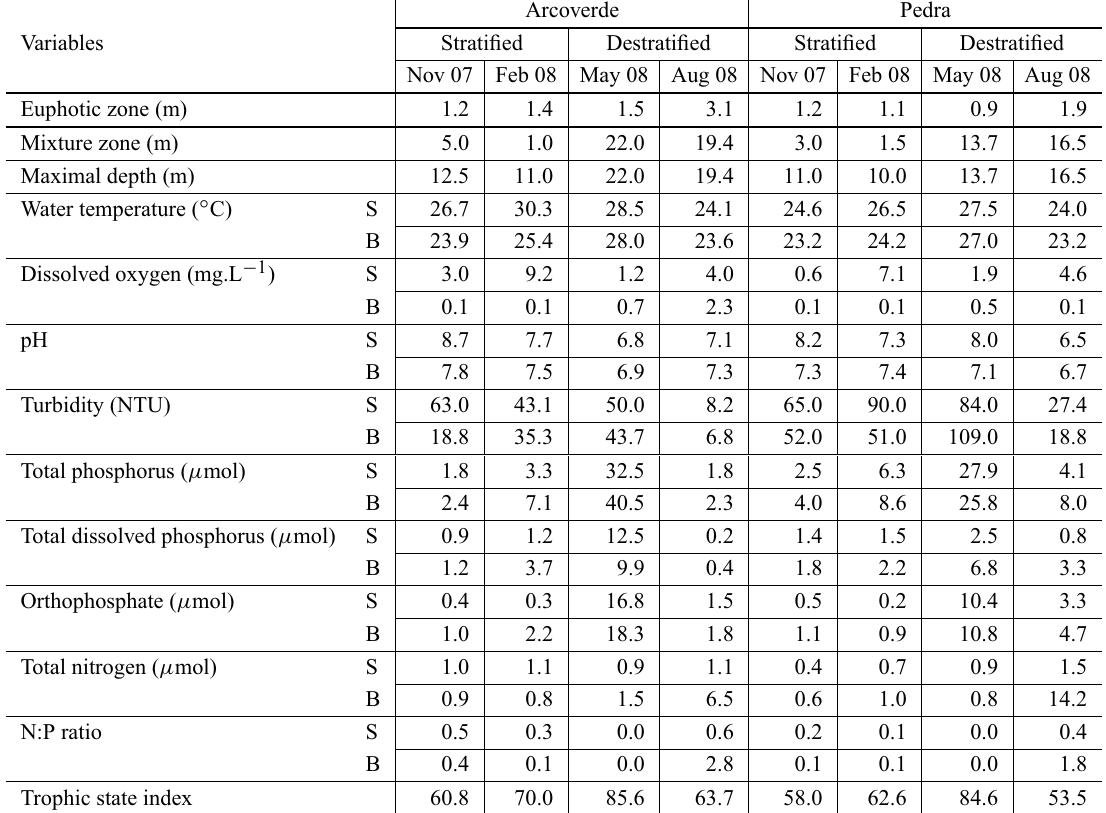
Values of variables determined at the subsurface (S) and bottom (B) of two reservoirs in the state of Pernambuco, Brazil, from November 2007 to August 2008. Arcoverde Pedra